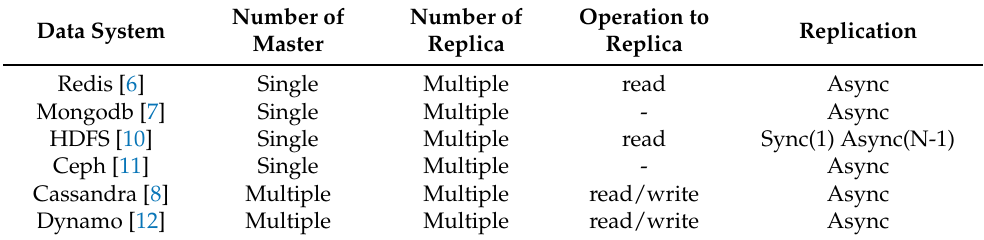
Table 1. Replication in distributed